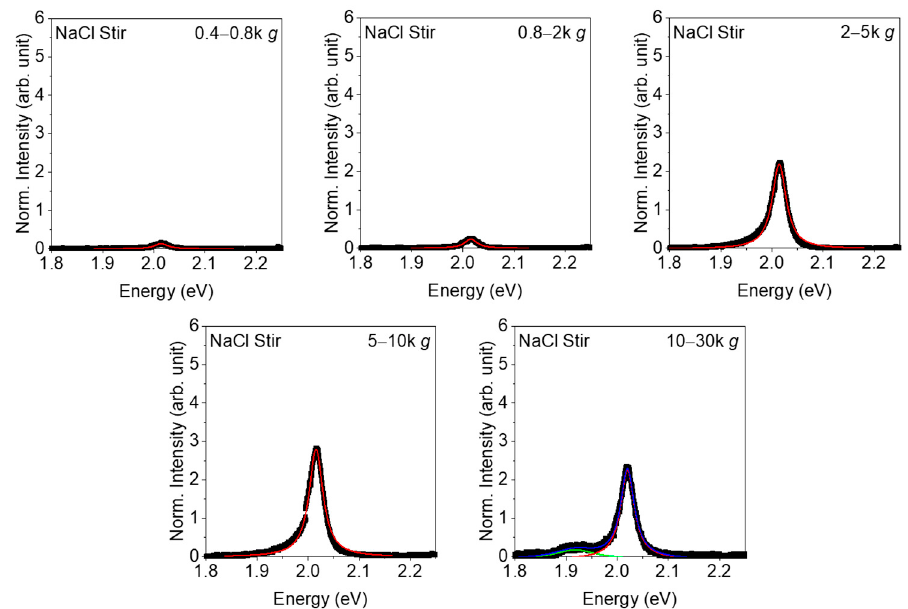
Figure A6. Photoluminescence spectra ( λ exc = 532 nm) the WS 2 nanosheet dispersions, exfoliated by tip sonication with a 30% amplitude. The bulk starting material was stirred in H 2 O/NaCl prior to exfoliation. The PL was fitted by Lorentzians for quantitative analysis. Spectra of fractions which were collected during liquid cascade centrifugation but did not show any PL are excluded.